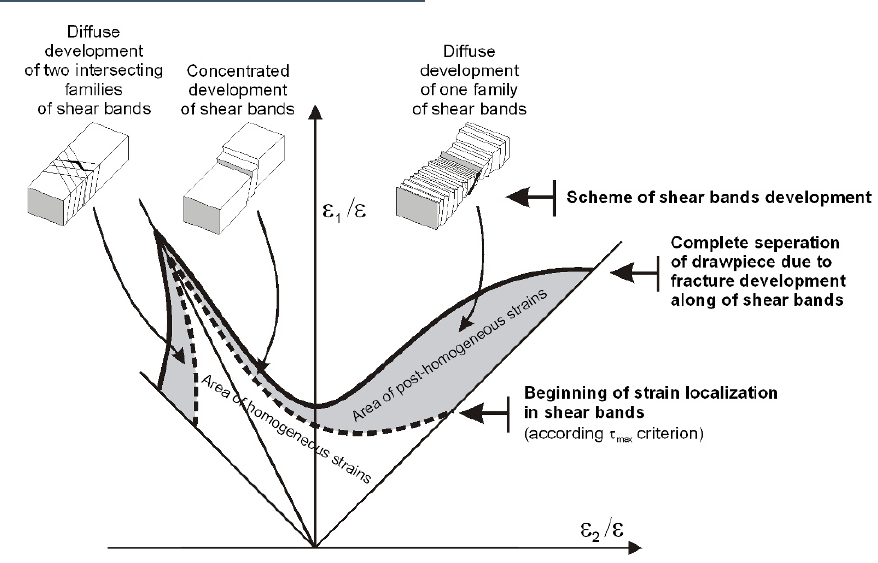
Figure 13. Proposed new, mesoscopic concept of limit diagram for metal sheet forming.